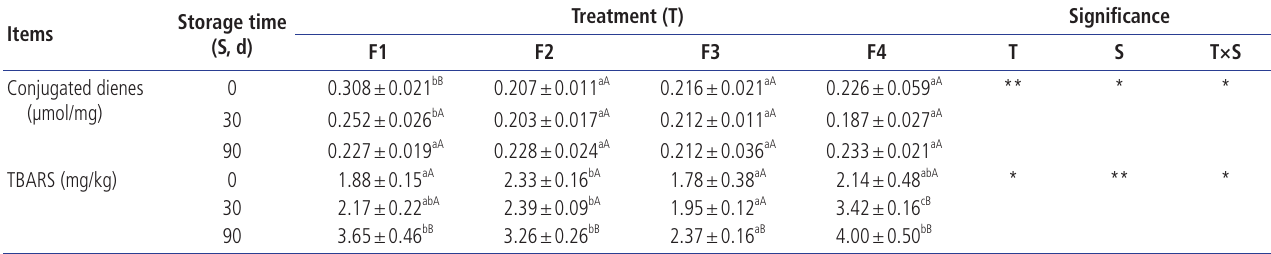
Table 3. Primary and secondary products of lipid oxidation of fermented venison sausage (mean values±standard error of the mean) Storage time Items (S,